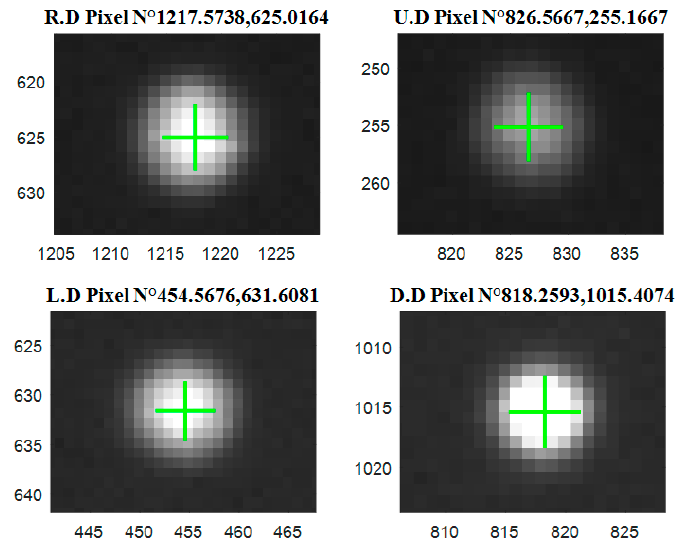
Figure 5. Results of laser’s spot subpixel center positioning.